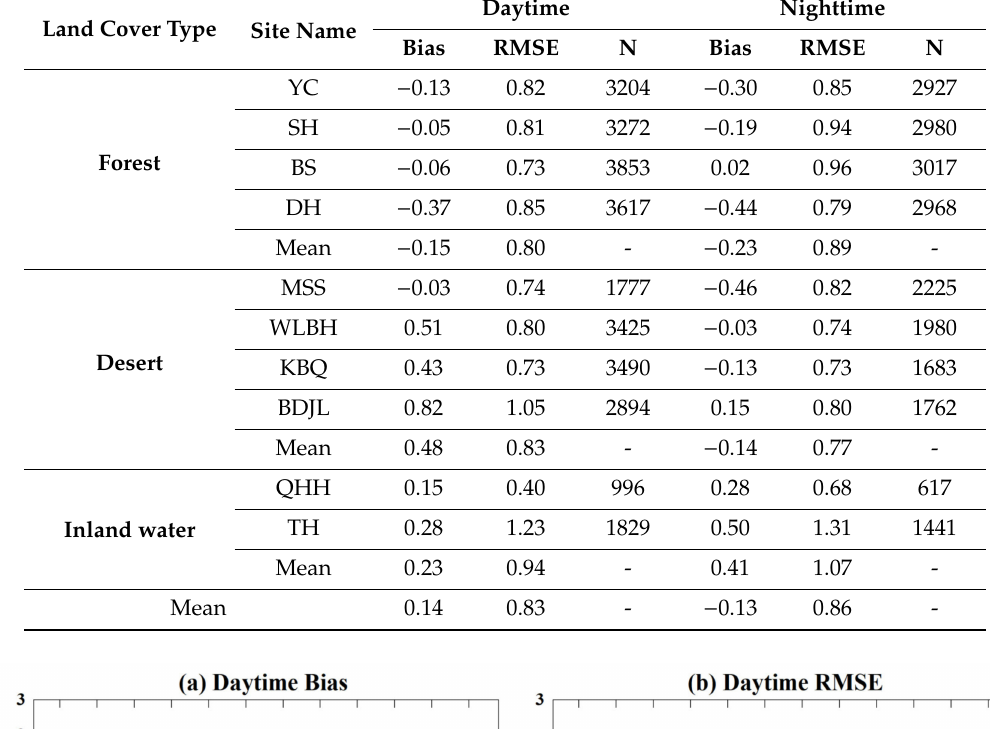
Table 9. AHI LST R-based validation results at each site during the daytime and nighttime.